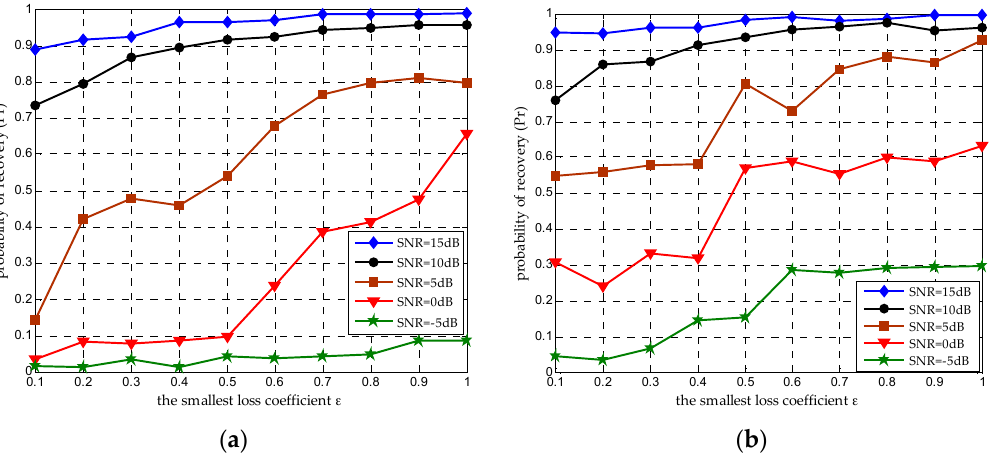
Figure6. The curvilinear relation between  and P under different SNR levels, when the amount Figure 6. The curvilinear relation between ε and P r under different SNR levels, when the amount of r sub-bands is N = 6 and the number of cooperative SUs is m = 50. Simulations results are presented of sub-bands is 6 N  and the number of cooperative SUs is 50 m  . Simulations results are for ( a ) CR = 0.25 and ( b ) CR = presented for ( a ) CR = 0.25 and ( b ) CR = 0.5.